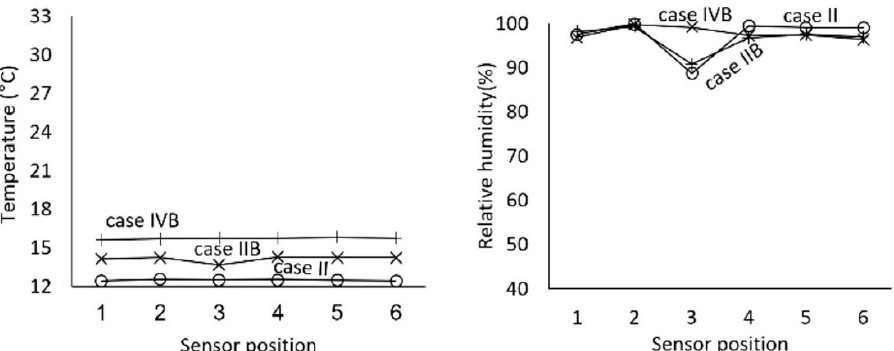
Figure 5. Variation of temperature (°C) and RH (%) for night-time period.